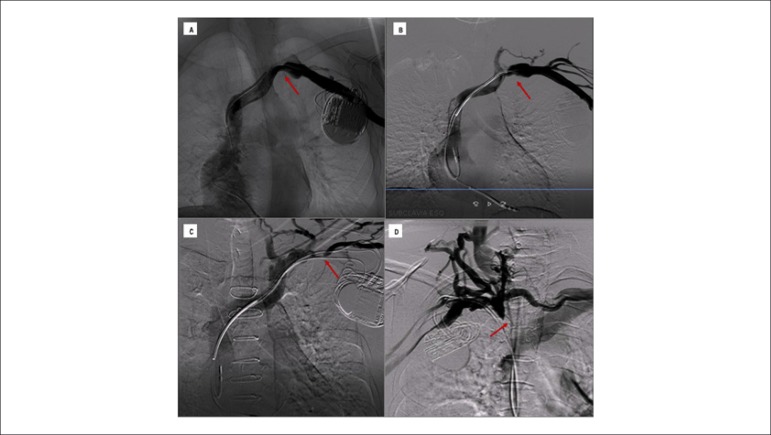
Classification of venous lesions and collateral circulation. Examples
of the four types of lesion according to the classification adopted
in the study. Figure 3A: non-significant lesions characterized with
obstruction of less than 50% of the blood vessel lumen and absence
of collateral circulation; Figure 3B: moderate lesion in 51% to 70%
of the vessel, with discrete collateral circulation; Figure 3C:
severe lesion compromising 71% to 99% of the vessel with moderate
collateral circulation; Figure 3D: venous occlusion with accentuated
collateral circulation.